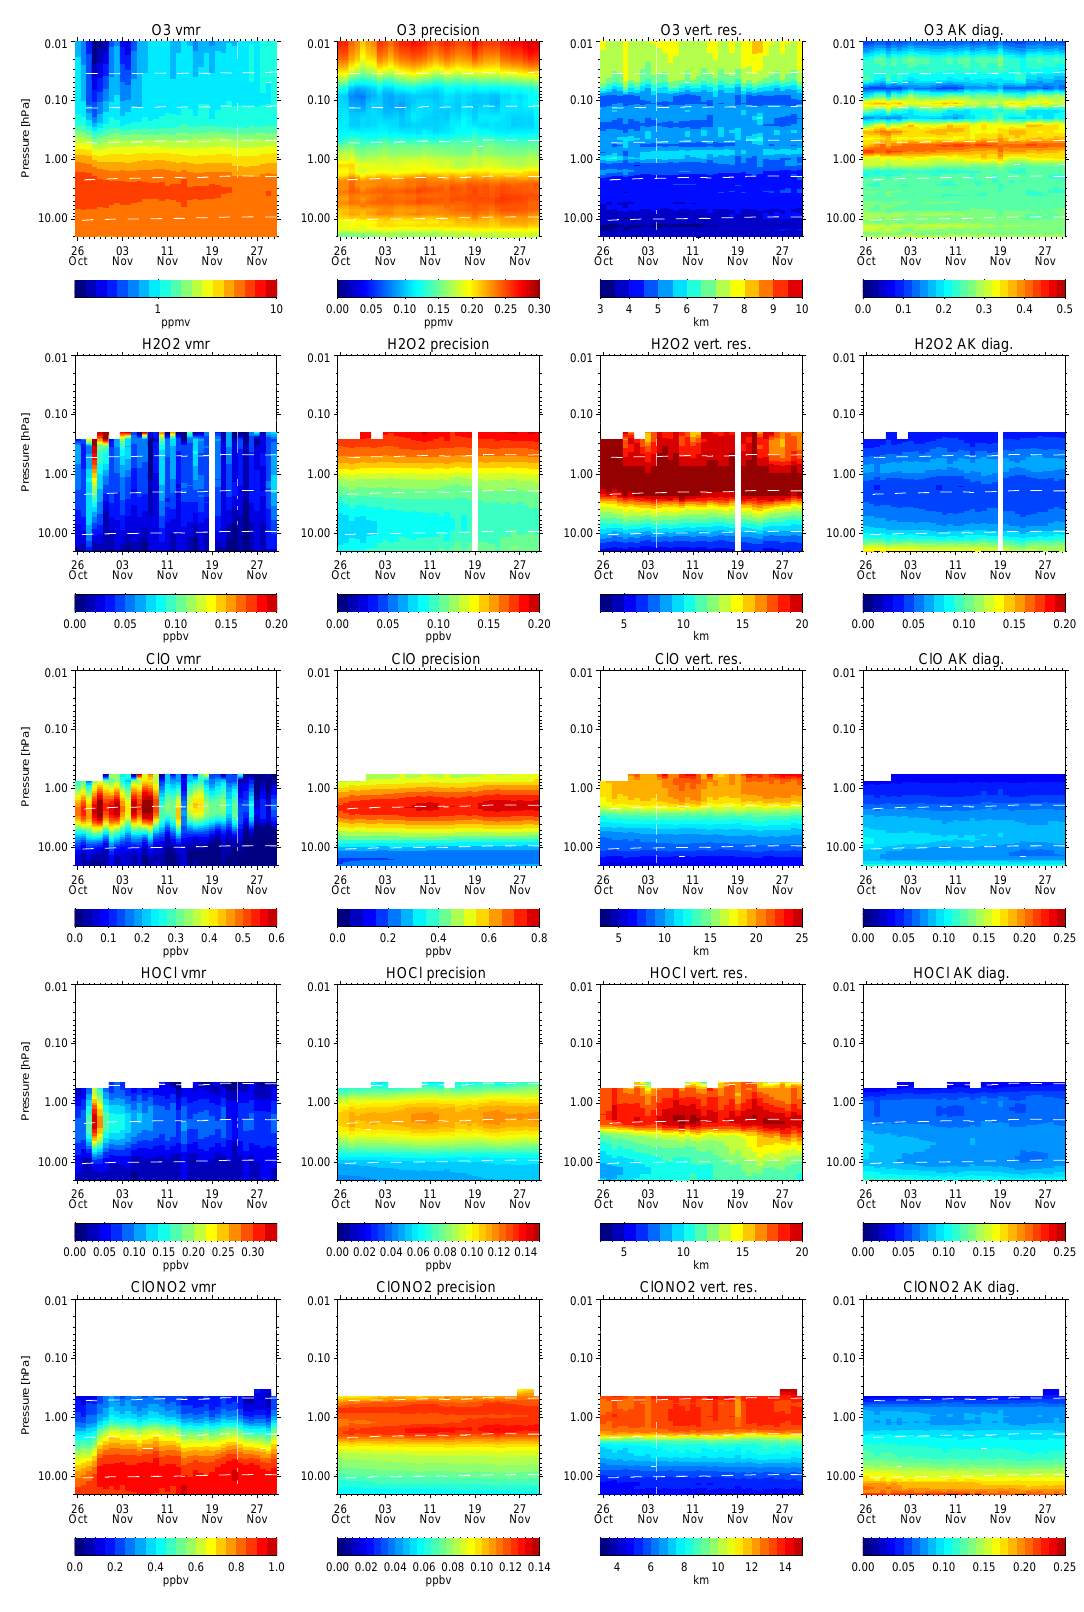
Fig. 3. Same as Fig. 2, but for O 3 , H 2 O 2 , ClO, HOCl, and ClONO 2 Fig. 3. Same as Figure 2, but for O